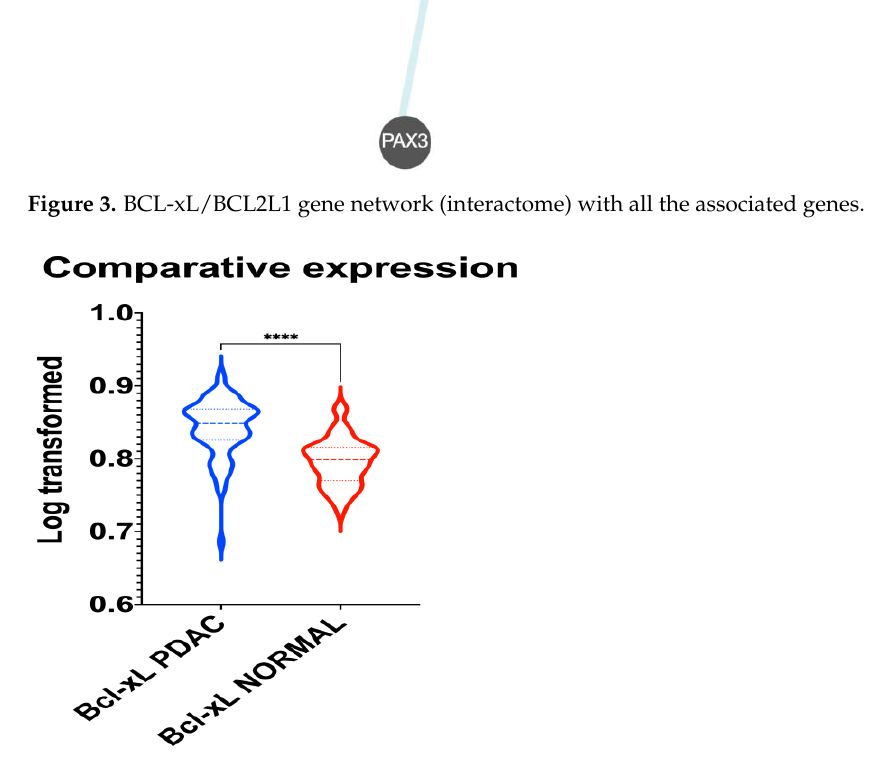
Figure 4. Violin plot demonstrating the differential gene expression of BCL-xL in normal and PDAC tissue samples. ****: p < 0.001 tissue samples. ****: p <